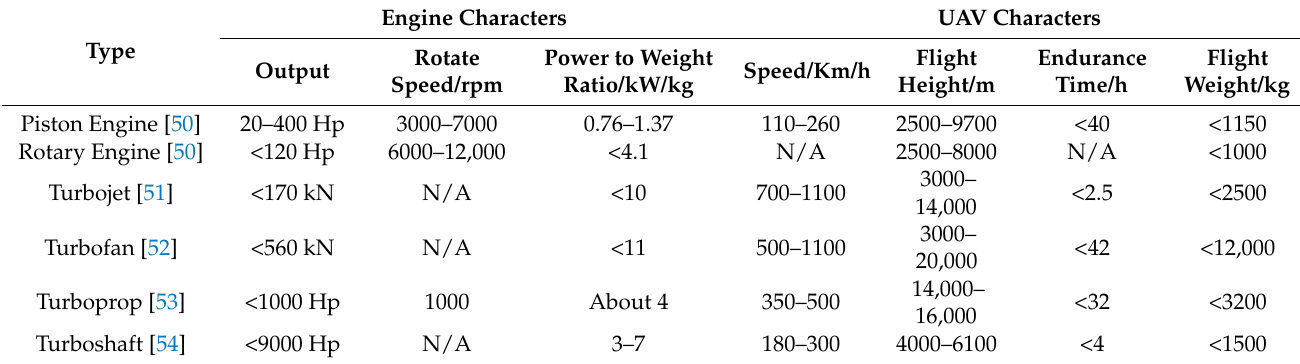
Figure 6. Composition of the fuel propulsion system for UAVs. Table 2. Different Oil-Based Engine Characters.